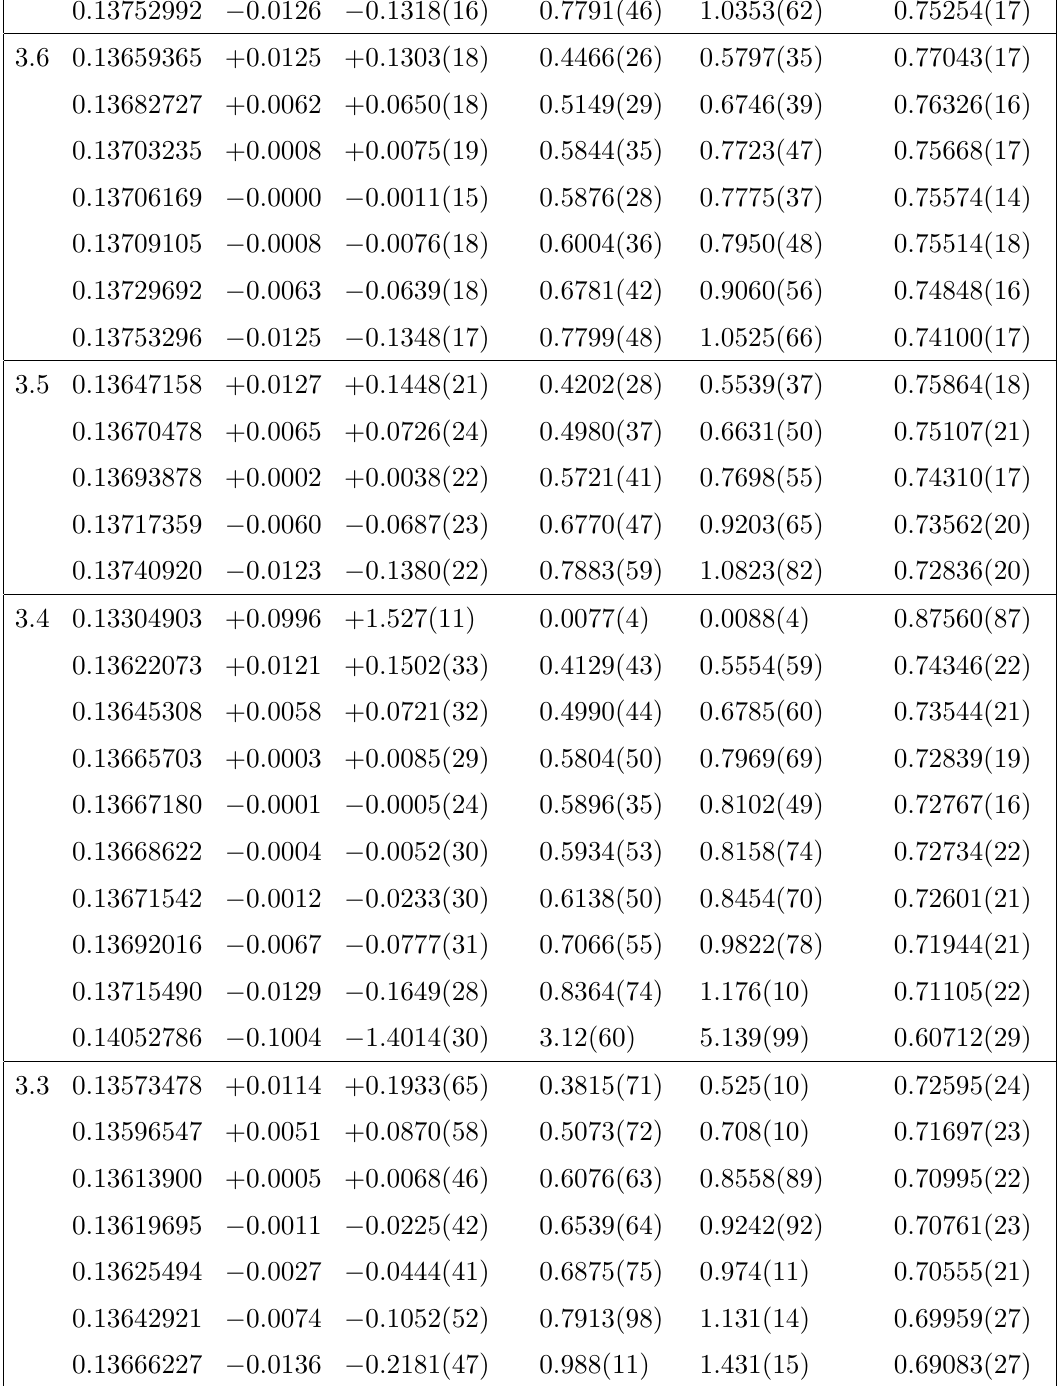
Table 2. Unitary simulation points with corresponding current quark mass and correlator results. After thermalization, the majority of simulations has accummulated ensemble sizes of 5000 con(cid:12)gu- rations or more, separated by 4 molecular dynamic units each. Measurements have been performed on each